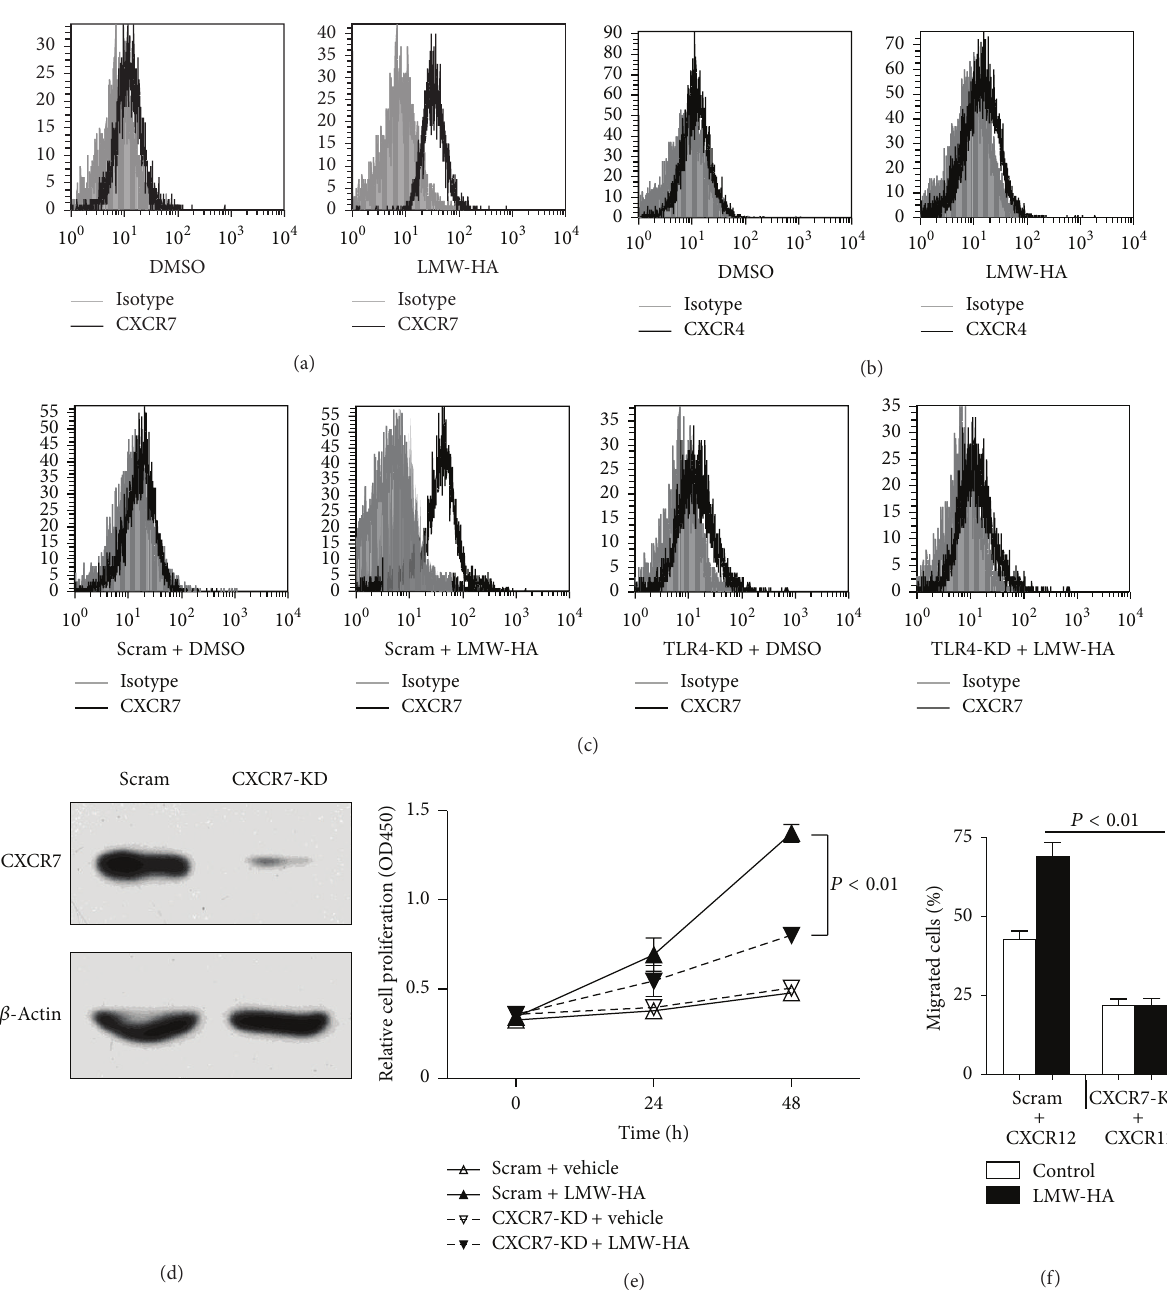
Figure 3: LMW-HA upregulates CXCR7 to promote W3 cell proliferation and migration. ((a)-(b)) W3 cells were incubated with LMW- HA (100 𝜇 g/mL) for 24 h; representative flow cytometric analysis of CXCR7 (a) or CXCR4 (b) expression was shown. (c) Scram-W3 cells and TLR4-KD W3 cells were treated with or without LMW-HA (100 𝜇 g/mL) for 24h; representative flow cytometric analysis of CXCR7 expression was shown. (d) W3 cells were transfected with scrambled shRNA (Scram) or CXCR7 shRNA-expressing constructs (CXCR7-KD), and subjected to immunoblot analysis. (e) Scram-W3 cells and CXCR7-KD W3 cells were seeded into 96 well plates (2,000 cells/well) and treated with or without LMW-HA. Cell proliferation was analyzed. Data are mean ± SEM for three independent experiments. (f) Scram- W3 cell and CXCR7-KD W3 cell migration to CXCL12 treated with or without LMW-HA was determined. Data are mean ± SEM for three independent